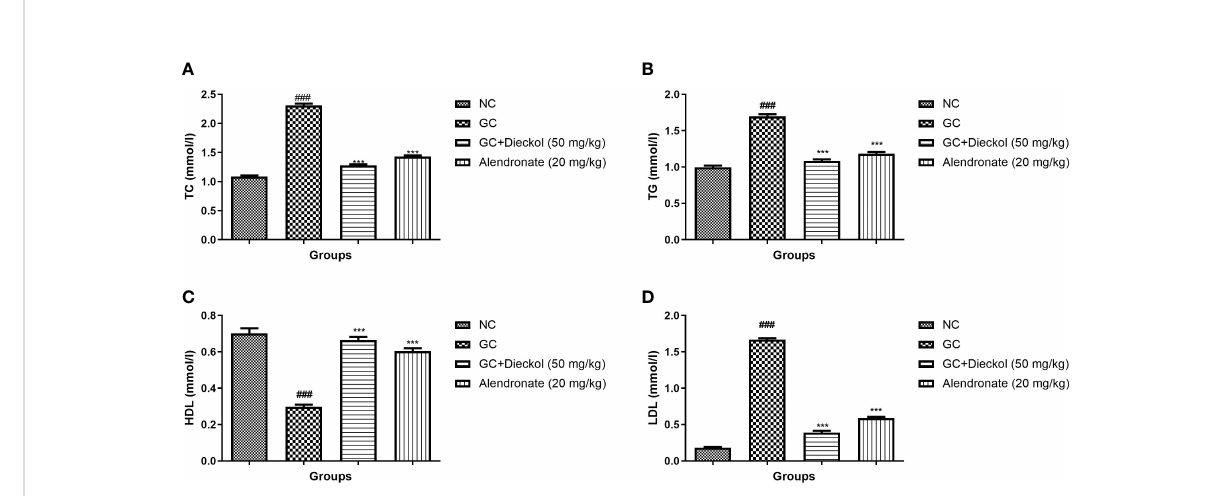
FIGURE 6 Dieckol was shown to protect lipid parameters against glucocorticoid-induced osteoporosis in rats. (A) TC, (B) TG, (C) HDL, and (D) LDL. Results are shown as means ± SEM (n = 12). ***P < 0.001 when contrasted with the disease group and the normal group.